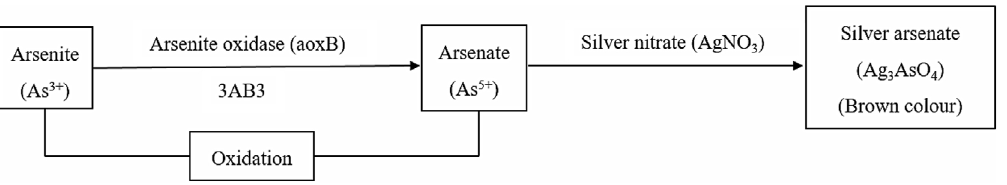
Fig. 3(b). Mechanism of arsenite to arsenate transformation by 3AB3 bacterial Fig. 3. Mechanism of arsenic species transformation by 5AB2 (3a) and 3AB3 (3b) bacterial isolates. This transformation mechanism was studied using microplate screening assay